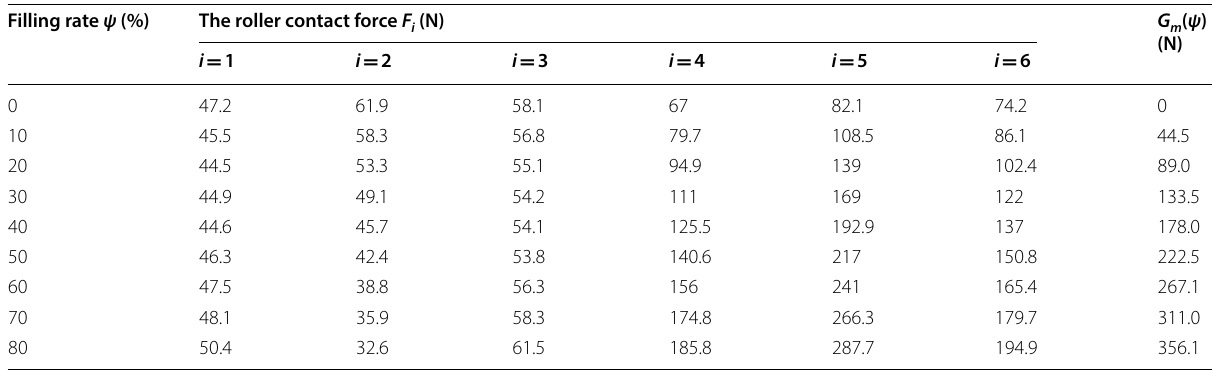
Table 1 The normal force in the case of different material filling rates Filling rate ψ (%) The roller contact force F i (N)